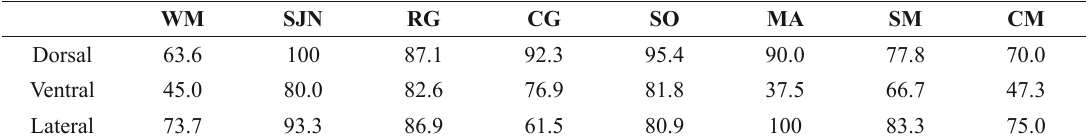
Percentage of correct classi fi cation from discriminant analysis for Scapteromys tumidus skull shape from eight geographic clusters in southern Brazil and